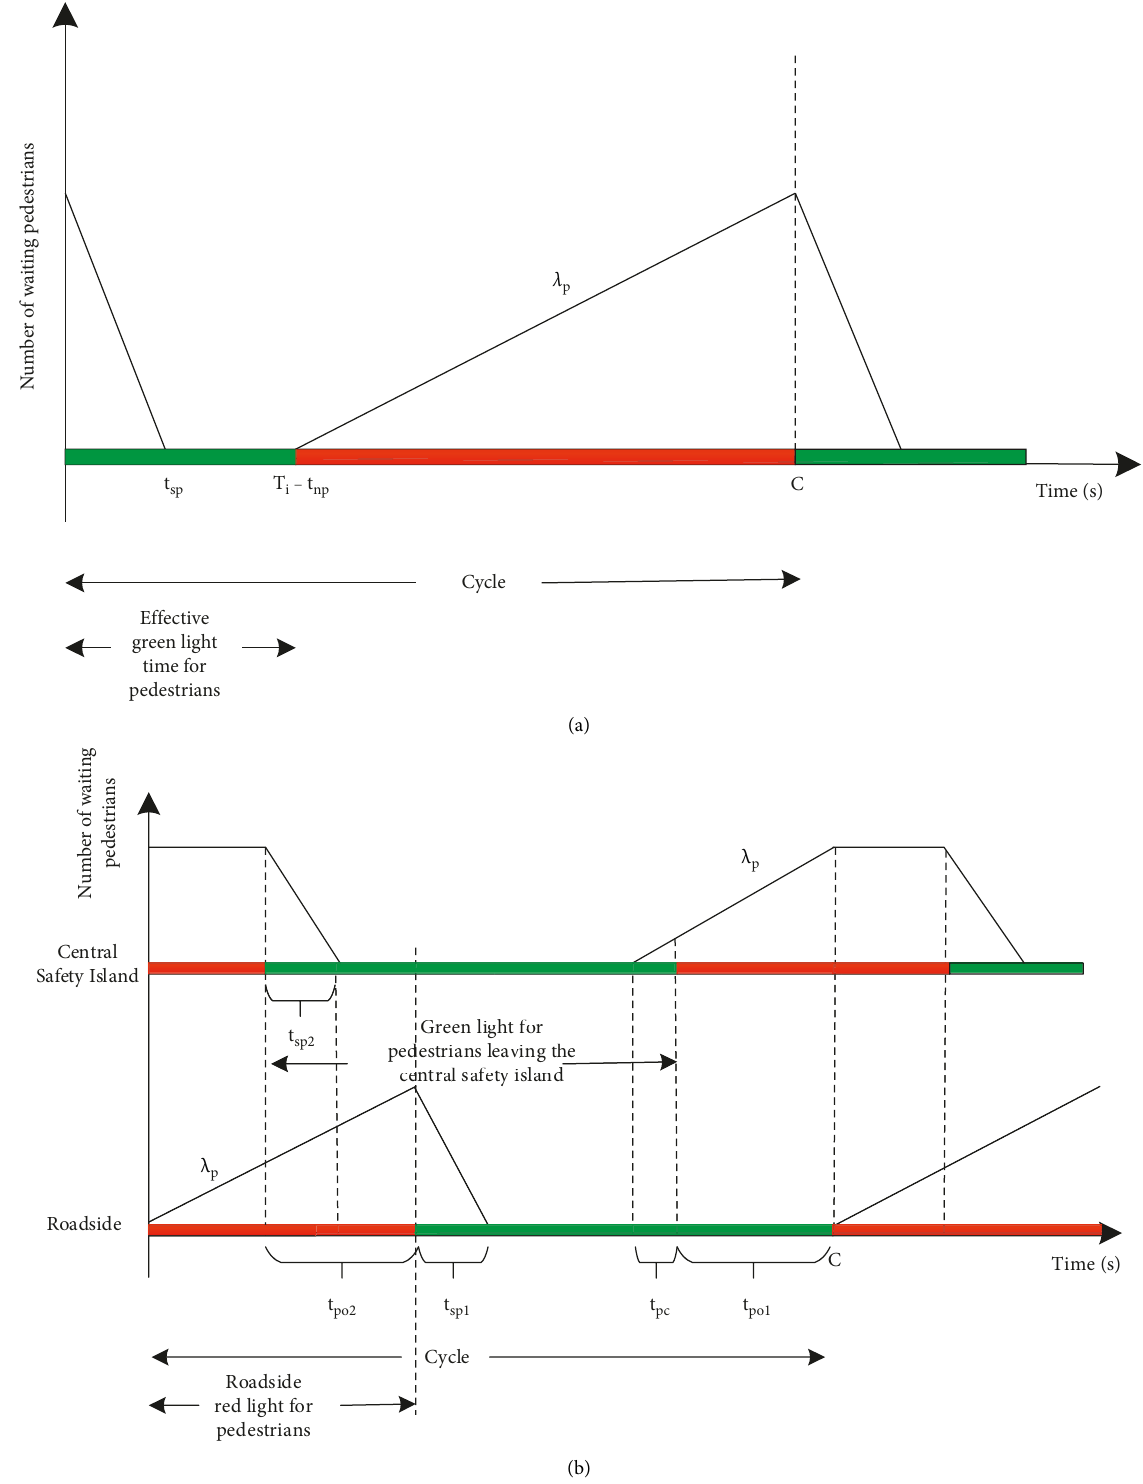
Figure 7: Diagram of pedestrians convergence and dispersion. (a) Pedestrian’s one-time crossing convergence and dispersion map. (b) Pedestrian’s two-times crossing convergence and dispersion